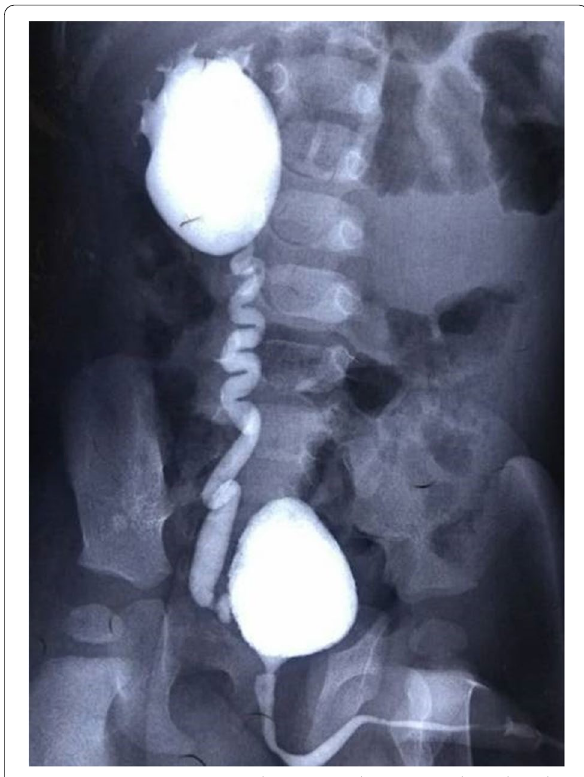
Fig. 1 Preoperative MCUG is showing grade 4 VUR on the right side with a dilated pelvis